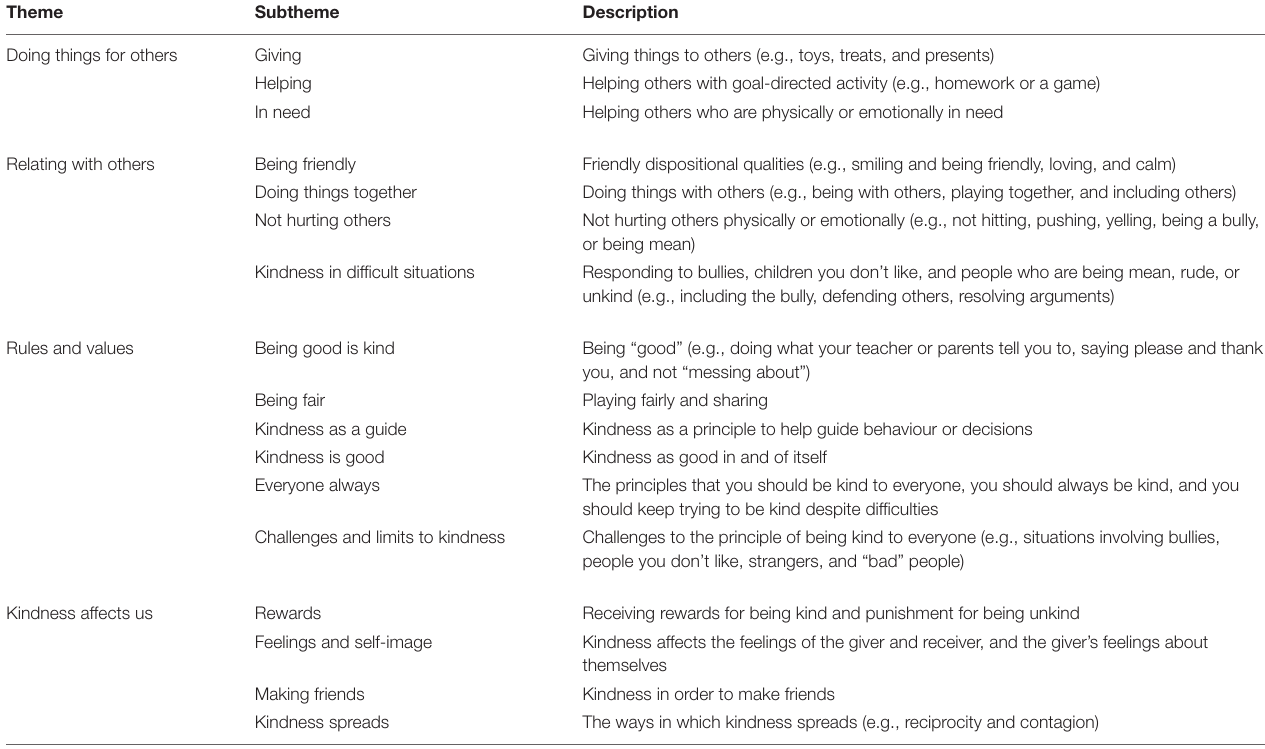
TABLE 1 | Description of themes and subthemes. Theme Subtheme